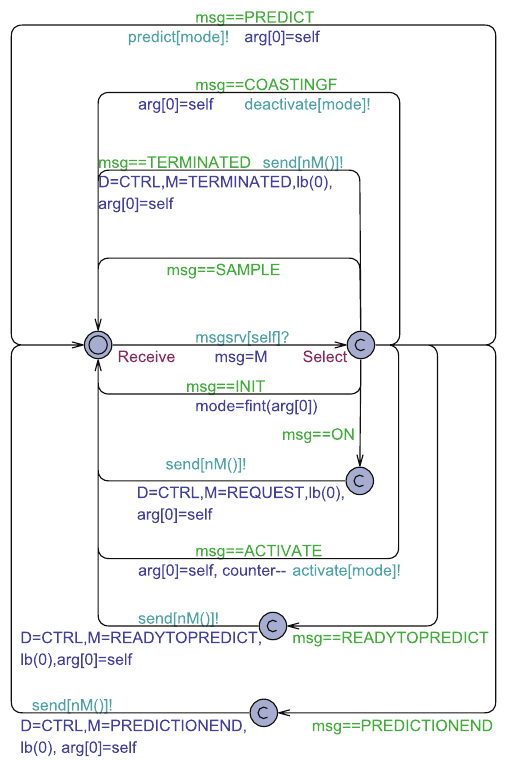
Figure 4. The Tabular Load actor